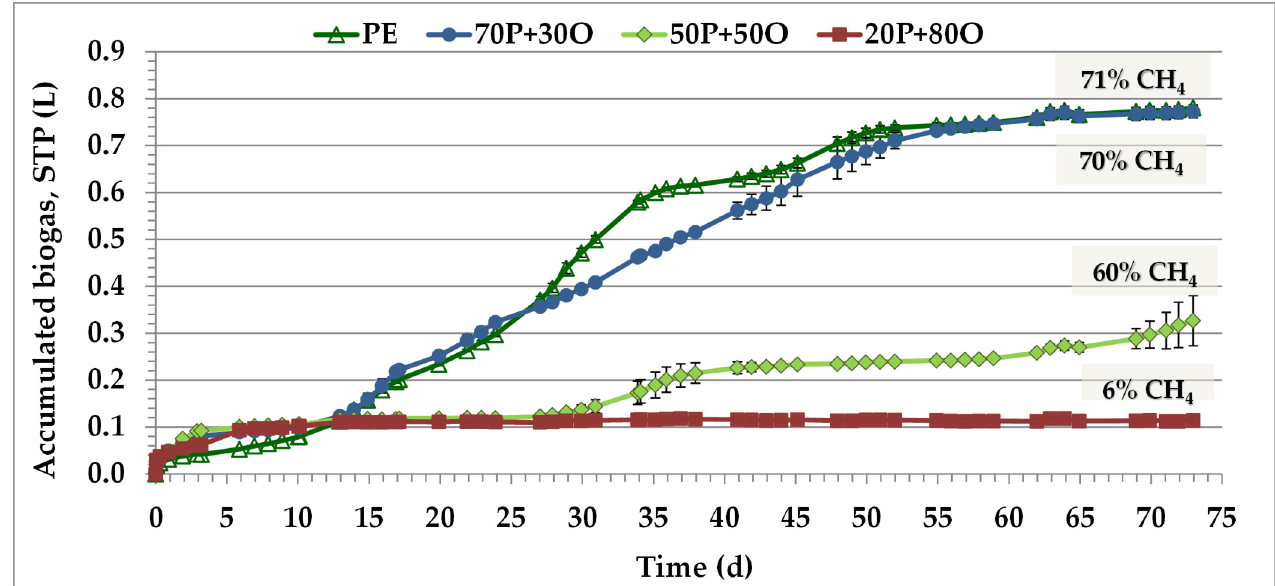
Figure 1. Anaerobic digestion of PE and OMW mixture: biogas production. STP—Standard temperature and pressure.